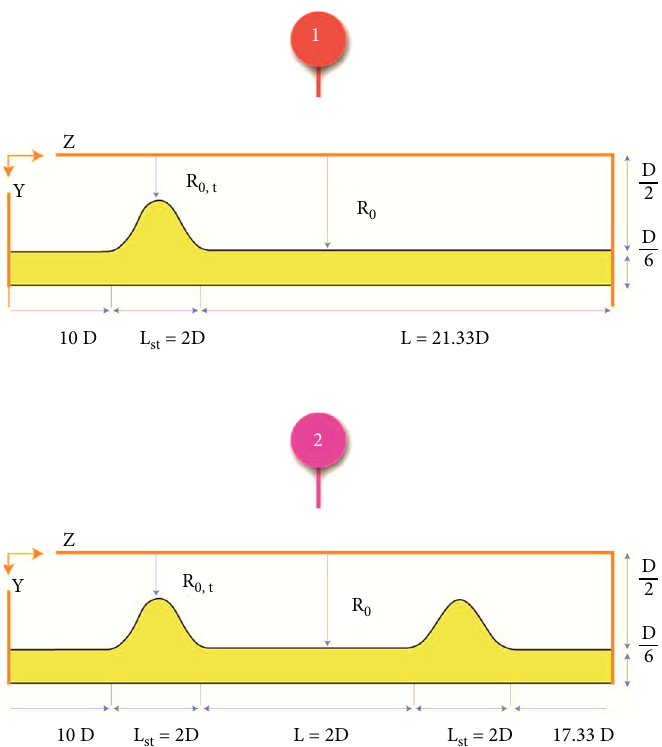
Figure 1: Calculation domain for an artery with (a) simple stenosis and (b) double